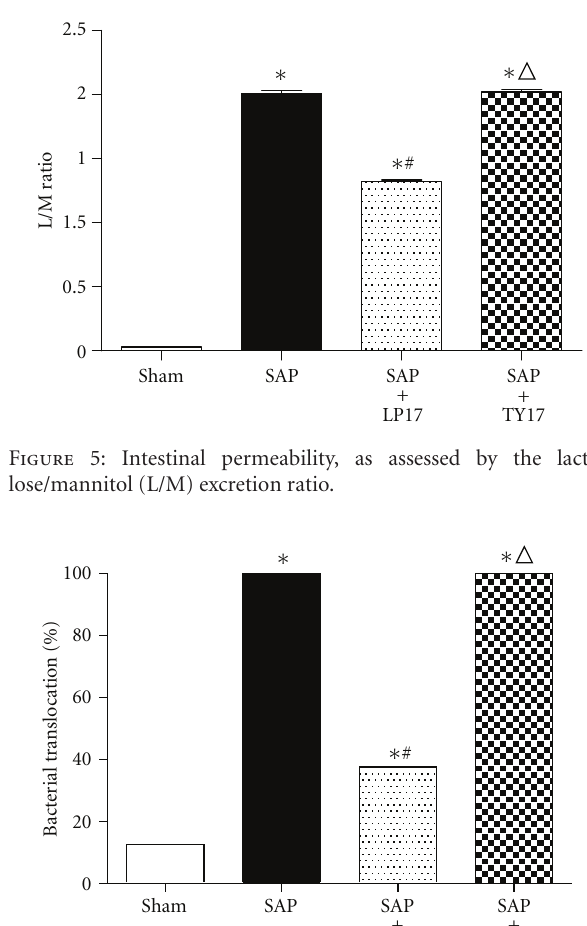
Figure 4: Levels of DAO and D-lactate in serum.